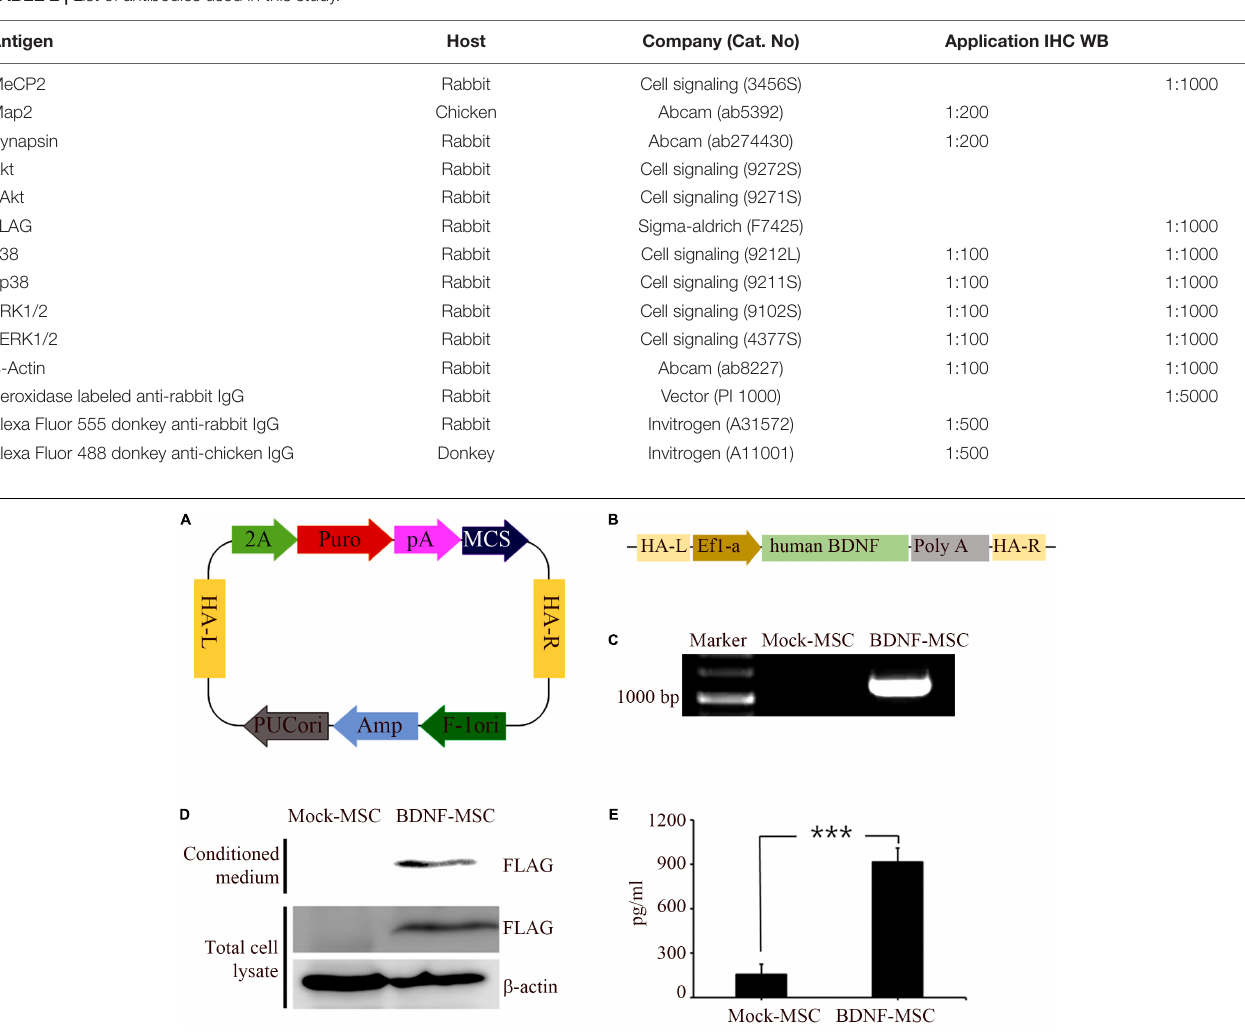
TABLE 2 | List of antibodies used in this study.